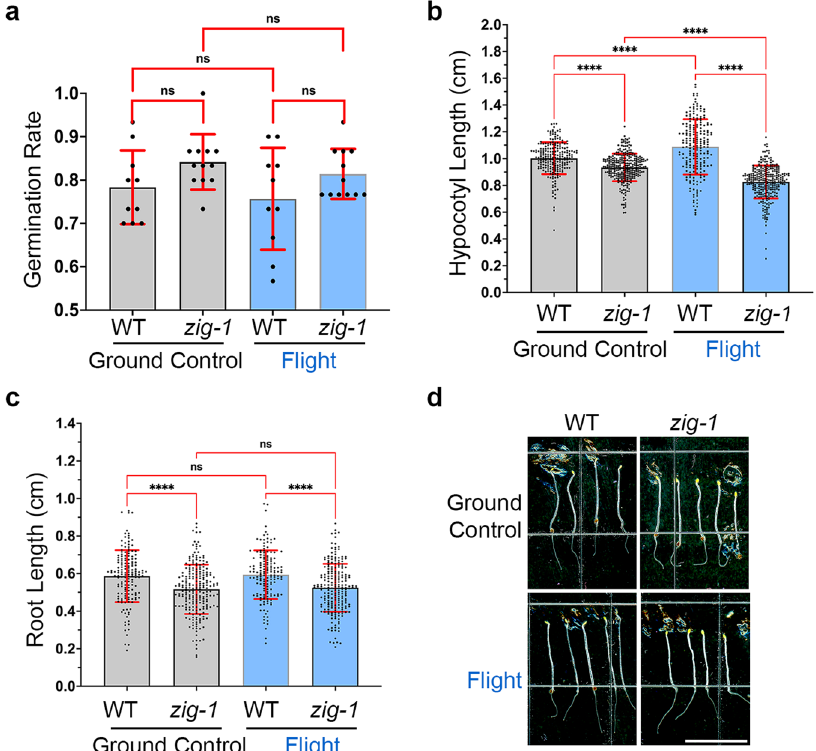
Fig. 3 WT and zig-1 in BRIC-PDFU can germinate and grow in microgravity environment as on earth. a Germination rate of WT and zig-1 grown in the BRIC-PDFU from ground control or fl ight. No differences were detected in the germination rate between genotypes or treatments. (Two-way ANOVA, Tukey ’ s multiple comparison test, ns: p > 0.1234, n represents plate number per genotype per treatment, n > 10). b Hypocotyl length of WT and zig-1 grown in the BRIC-PDFU from ground control and fl ight. WT showed longer hypocotyl than zig-1 both for ground control and fl ight. Flight assay promoted the hypocotyl length of WT while inhibited zig-1 ’ s hypocotyl length. (Two-way ANOVA, Tukey ’ s multiple comparison test, **** p < 0.0001, n represents seedling number per genotype per treatment, n > 200). c Root length of WT and zig-1 grown in the BRIC-PDFU from ground control and fl ight. The zig-1 mutant showed shorter roots than WT in both ground control and fl ight (Two-way ANOVA, Tukey ’ s multiple comparison test, **** p < 0.0001, n represents seedling number per genotype per treatment, n > 160). Raw datapoints are represented with fi lled circles. Error bars represent standard deviation. d Representative seedlings of the WT and zig-1 from either ground control or fl ight after de-integration of the BRIC-PDFU. Fixed seedlings were taken out of fi xative solution and arranged on plate. Scale bar: 1